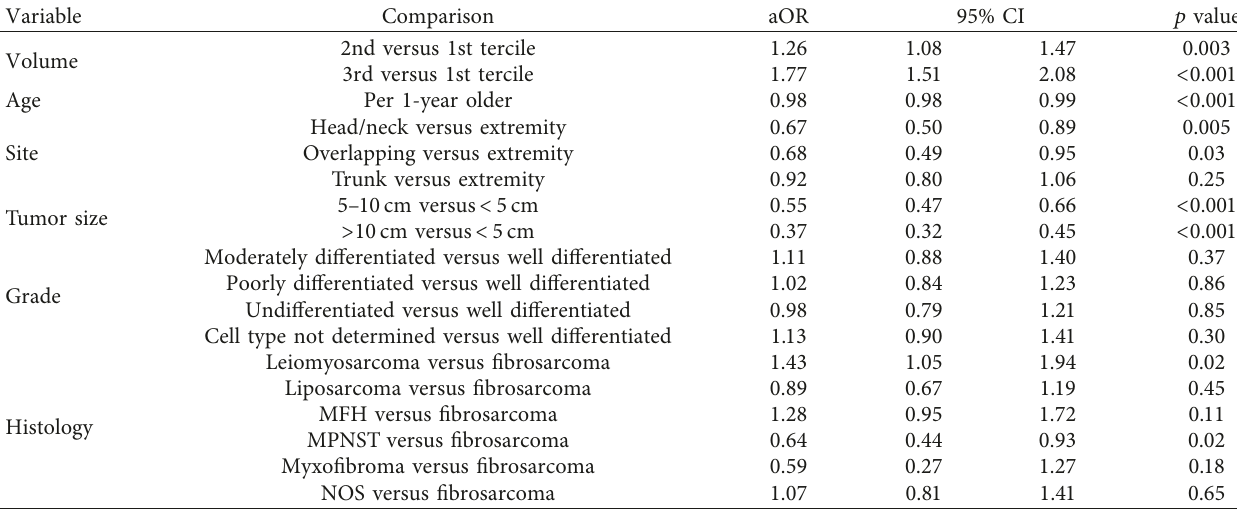
Table 5: Multivariable analysis for margin negative surgery ∗